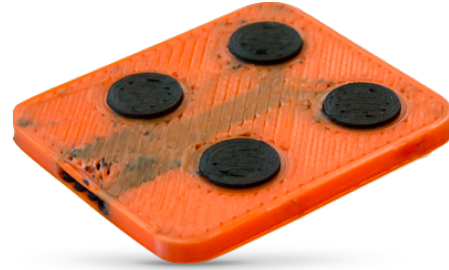
Figure 17. Photograph of 3-D printed sEMG electrodes, printed using a combination of conductive and dielectric TPU (Wolterink et al., 2017).